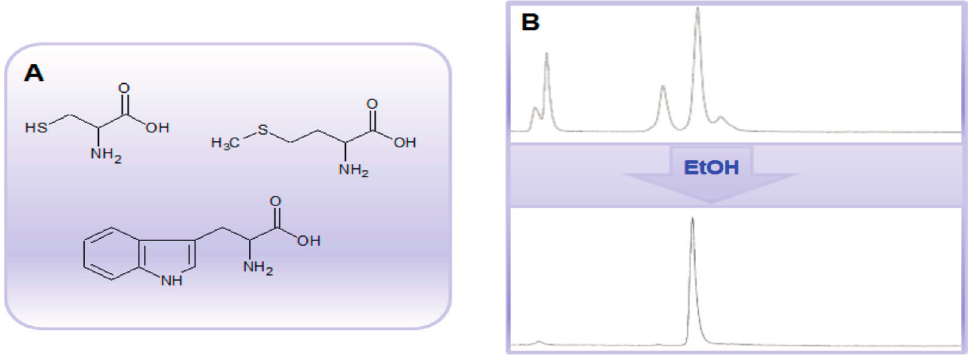
Figure 11. ( A ) Chemical structures of methionine, tryptophan and cysteine amino acid residues; ( B ) Radio-HPLC chromatograms of a crude 68 Ga-labeled protein comprising ~60 amino acid residues including several tryptophan and methionine amino acid residues without ( upper panel ) and with ( lower panel )